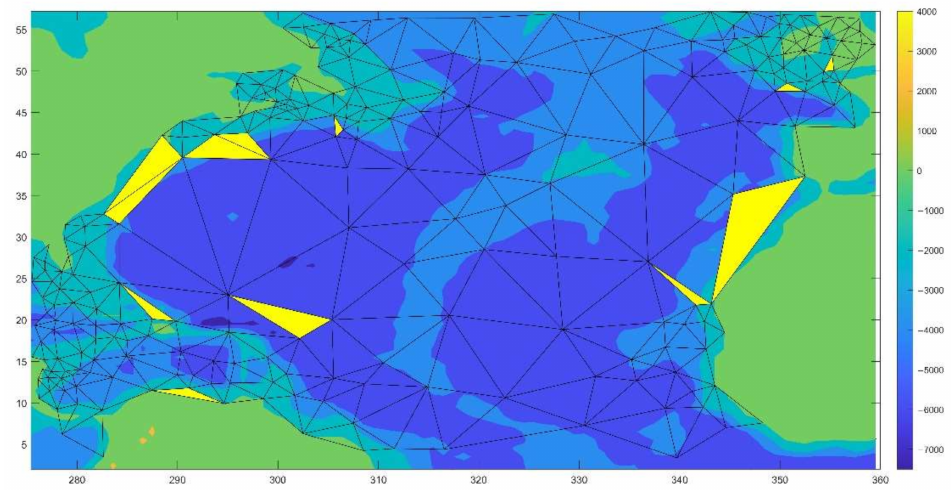
Figure 14. Optimization of the unstructured grid for a small area of sea.